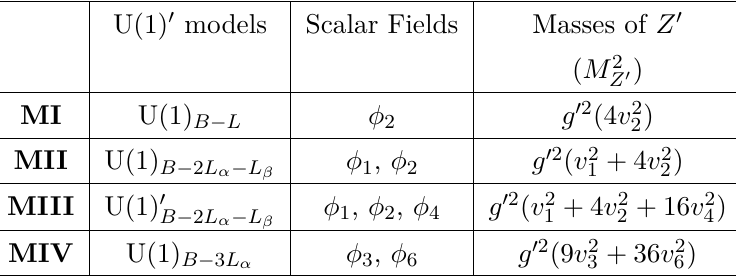
Table 2 . Singlet scalar fields φ i having charges i under U(1) 0